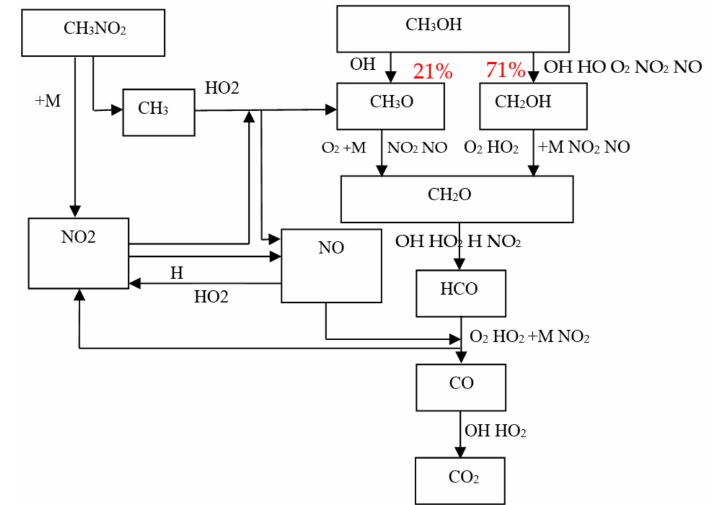
Figure 9. Elementary reaction pathways of methanol and nitromethane mixed